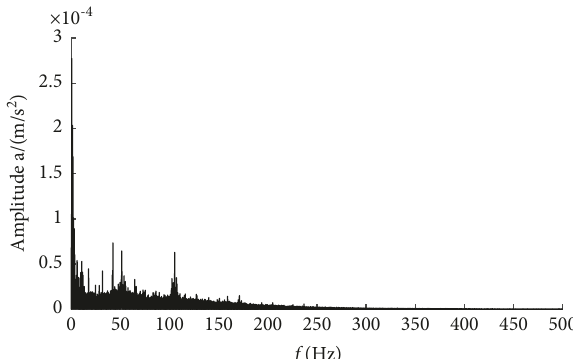
Figure 14: The envelope spectrum of the first component derived from BMD decomposition of a vibration signal from class 3.